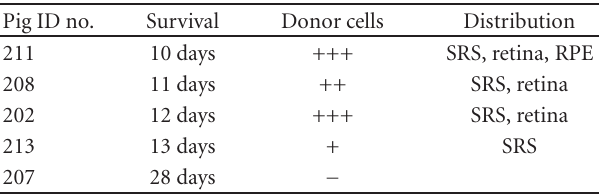
Table 2: Semiquantitative assessment of graft survival per pig and time point.